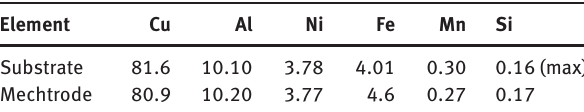
Table 1: Chemical composition of cast% of substrate and mechtrode material.